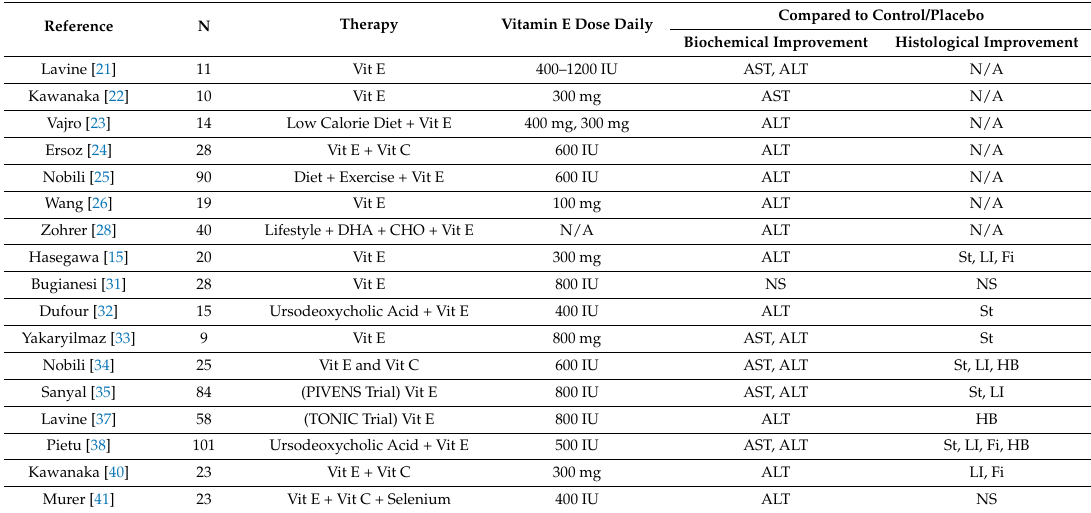
Table 1. Major clinical studies of vitamin E therapy for